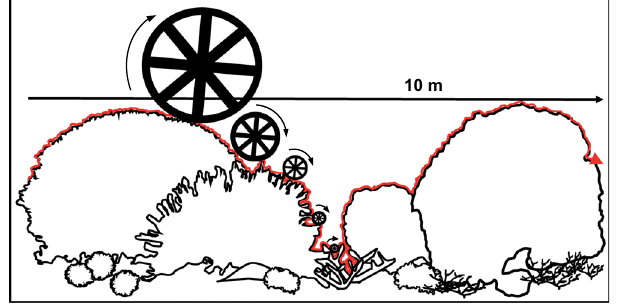
Figure 1. Contour distance estimated with five wheels of different diameters (4–64 cm) along a 10 m transect. Wheels closely follow the surface structure of the benthos and number of rotations are counted. Small wheels fit into more holes than larger wheels and thus estimate greater contour